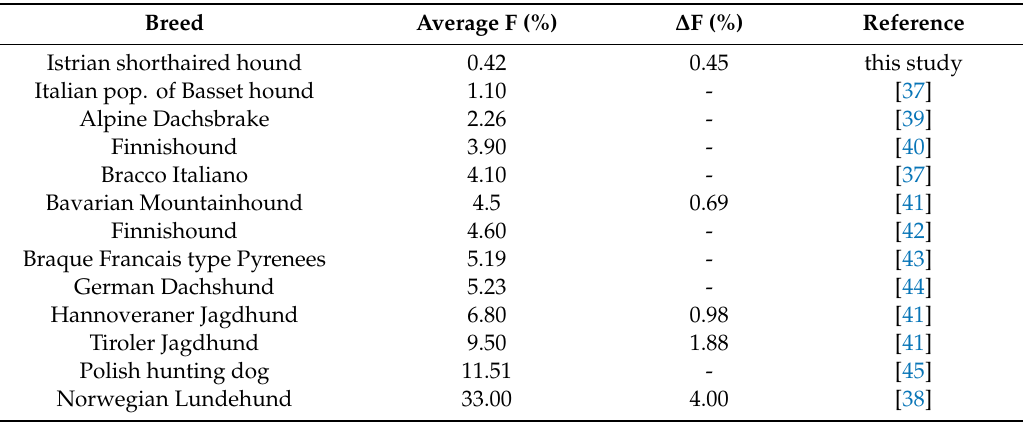
Table 7. Average inbreeding coe ffi cients (F) and inbreeding rate per generation ( ∆ F) in di ff erent dog breeds (data from this study and from the literature).